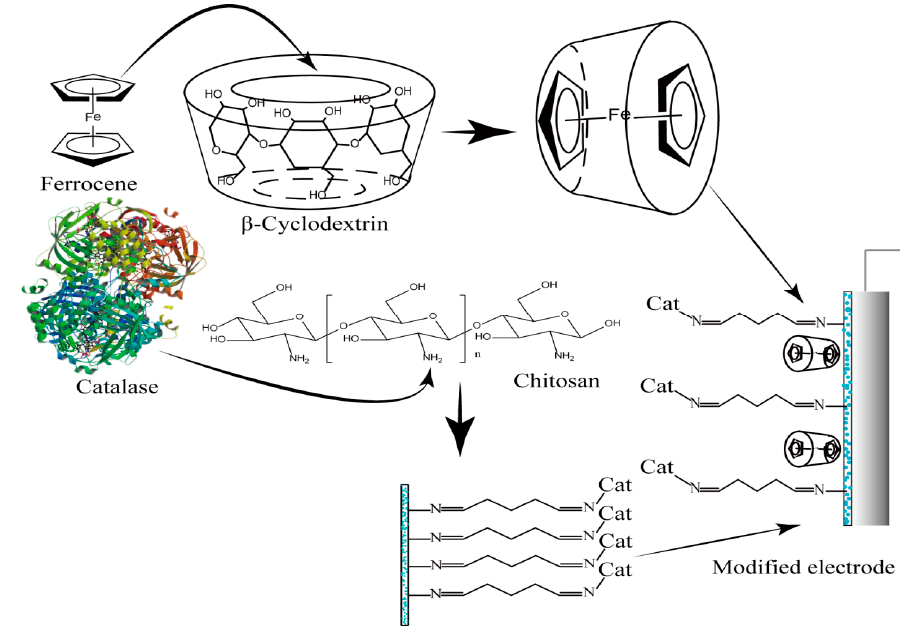
Figure 1. Schematic diagram of the CTS-CAT/ β -CD-FE composite electrode.